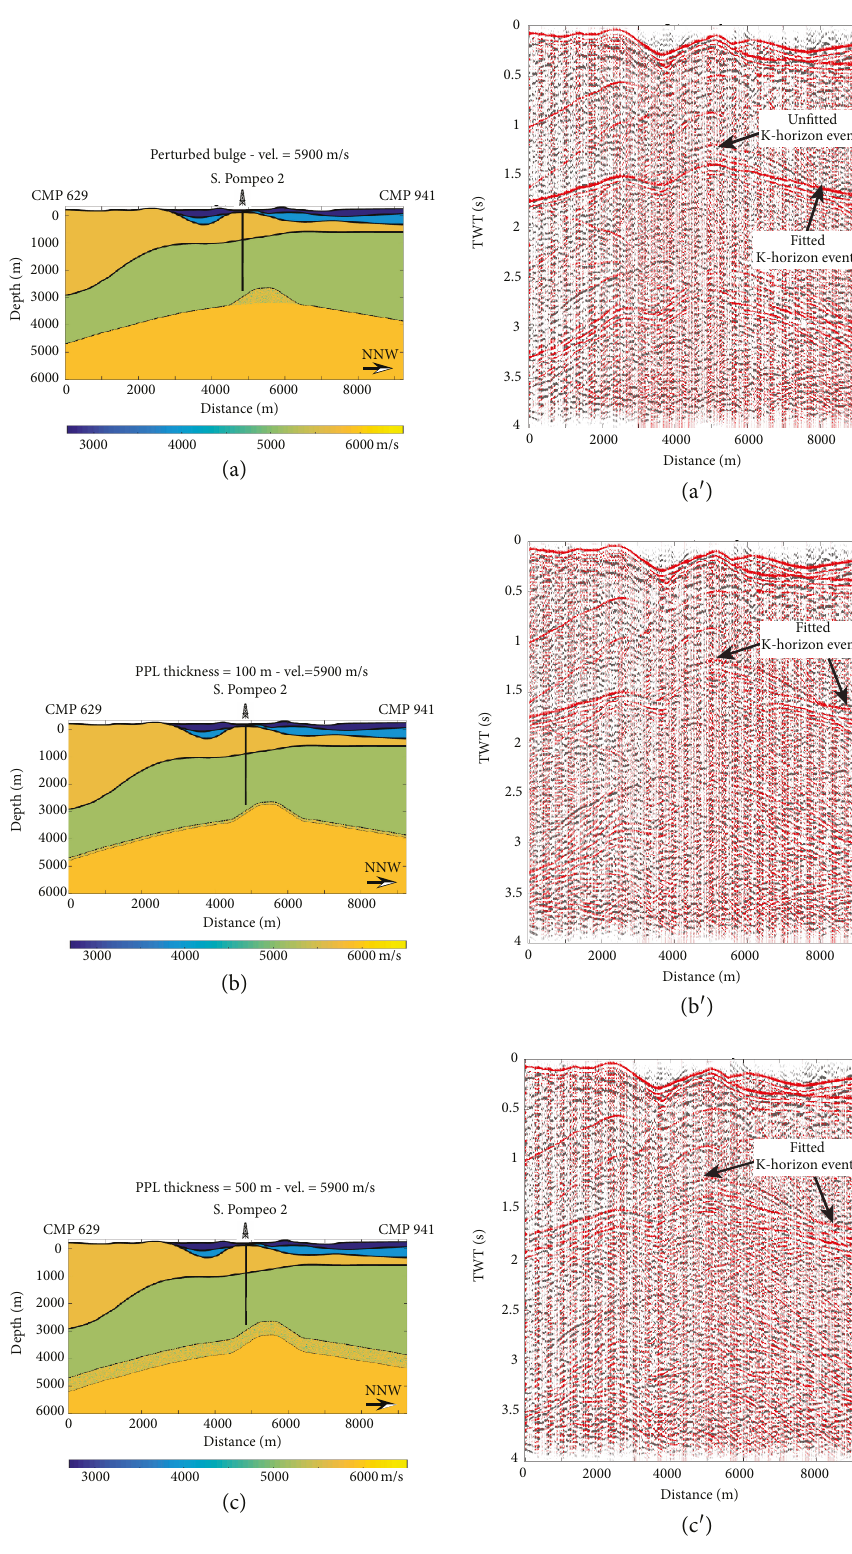
Figure 13: (a) Velocity model similar to the calibrated model in Figure 10 with a perturbed bulge. (b) Velocity model similar to the calibrated model in Figure 10 with a physical perturbed layer (PPL) of 100 m in thickness. (c) Velocity model similar to the calibrated model in Figure 10 with a physical perturbed layer (PPL) of 500 m in thickness. (a ′ ) Modelled stacked section for the velocity model in (a). (b ′ ) Modelled stacked section for the velocity model in (b). (c ′ ) Modelled stacked section for the velocity model in (c). The modelled seismic response, plotted in positive variable area in red, is superimposed onto the processed stacked data, plotted in